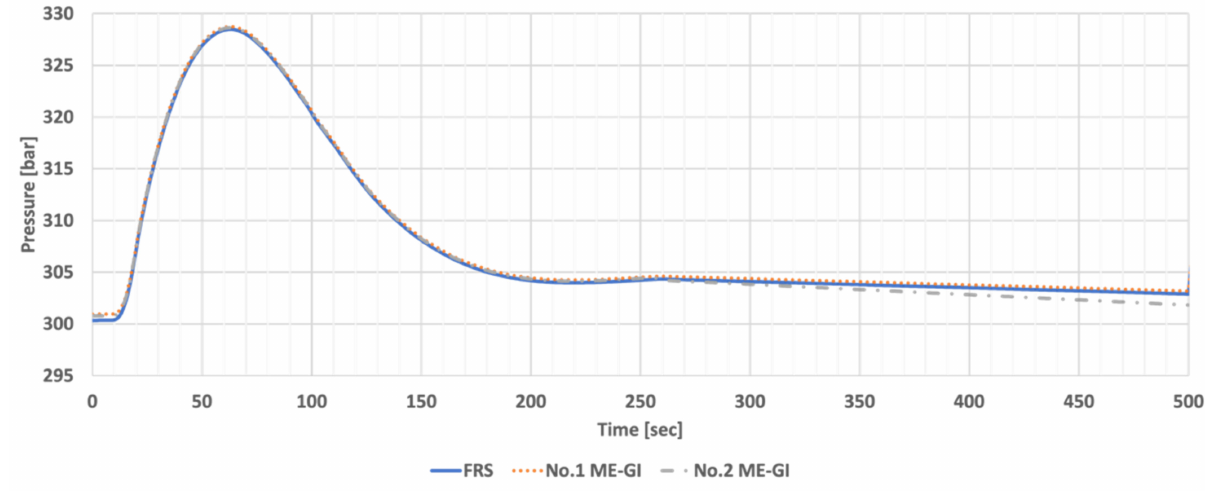
Figure 11. Pressure of each line when two engines are